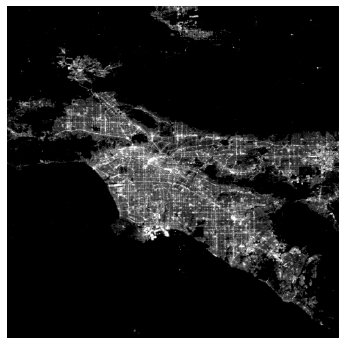
Figure 14. Nighttime image of Los Angeles (34 ° N), acquired with satellite in earth shadow area.